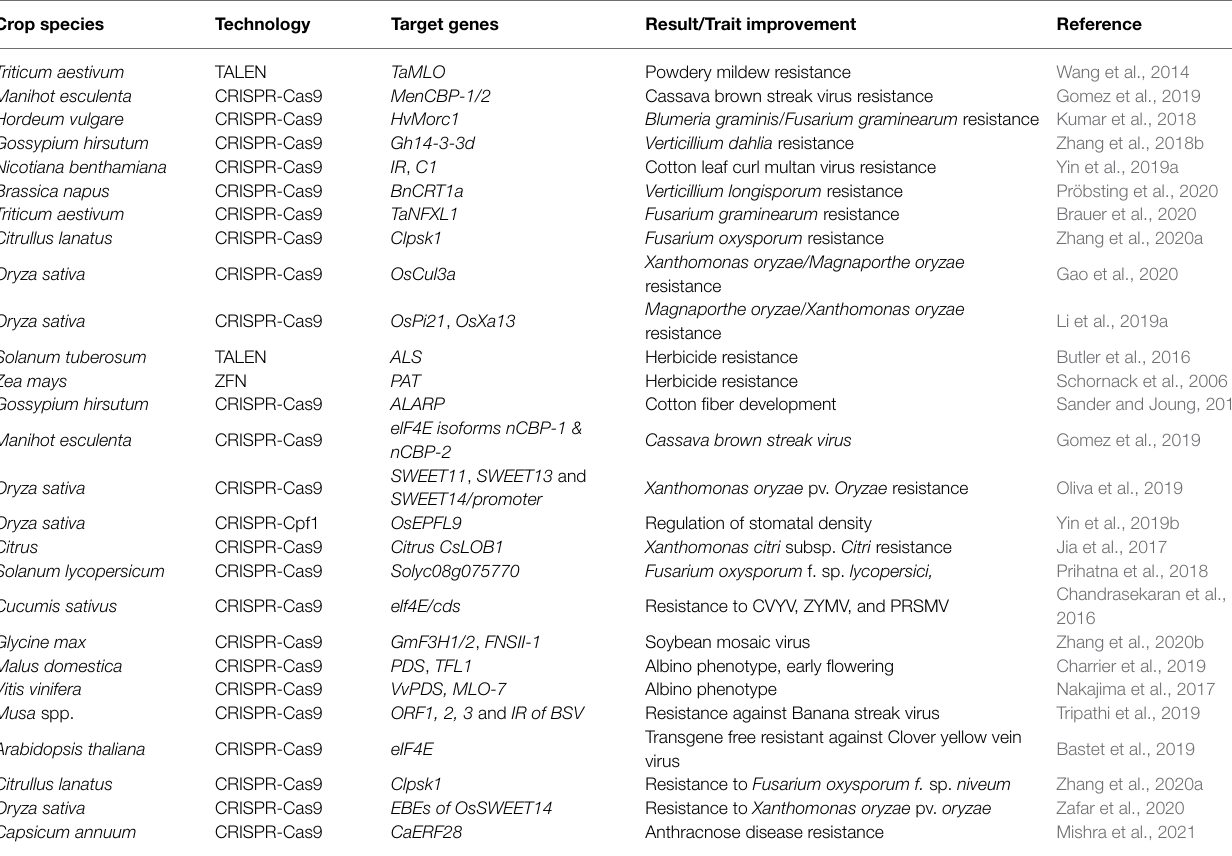
TABLE 1 | The application of diverse techniques for the improvement of different agronomic and disease resistance traits in crops species. Crop